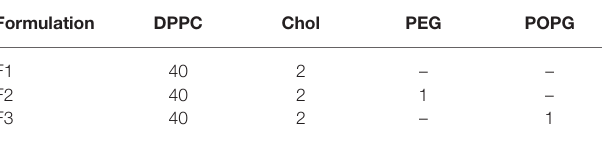
TABLE 2 | Lipid composition of the